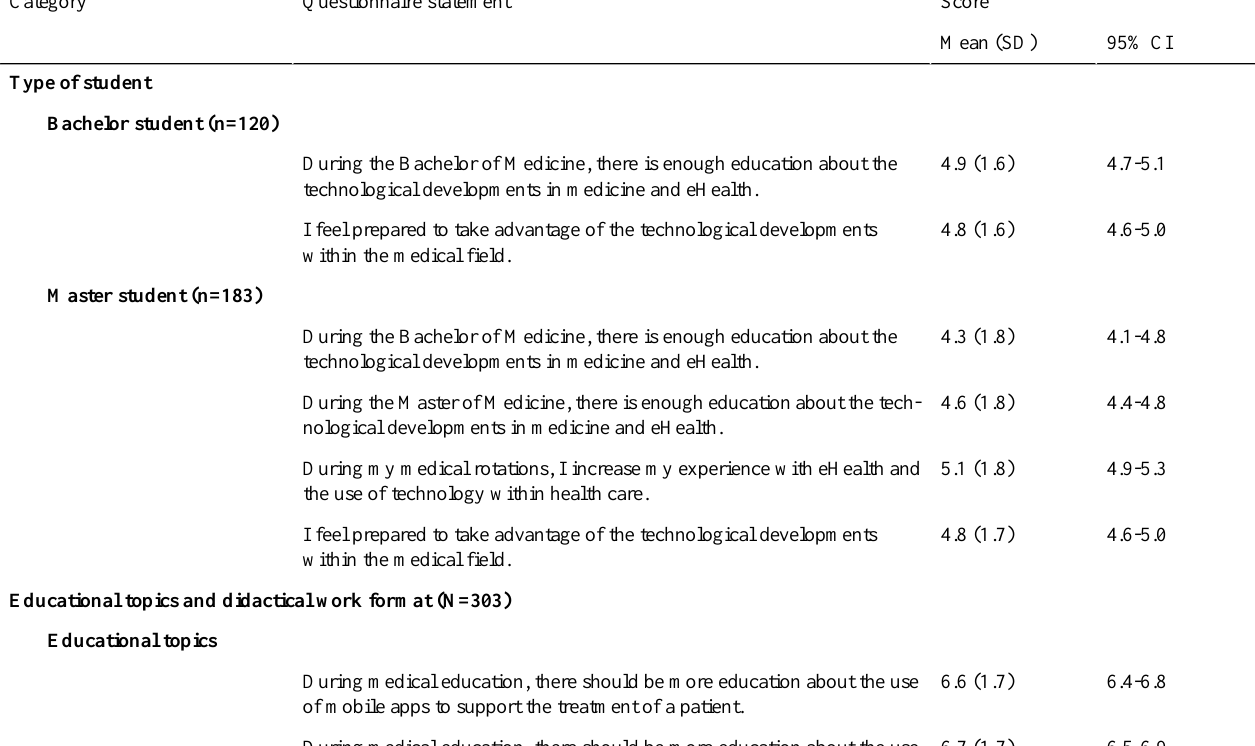
Table 2. Responses to statements regarding how prepared medical students feel with regard to eHealth and the education they would like to receive. ScoreQuestionnaire